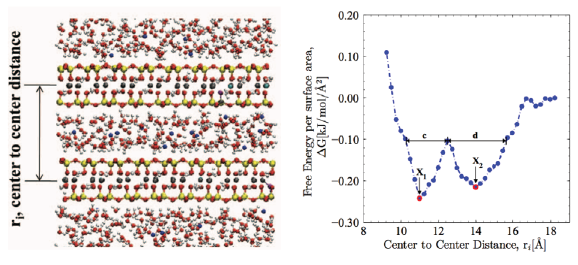
Figure 2: Face-to-face PMF for Sodium-Montmorillonite clay at 300K